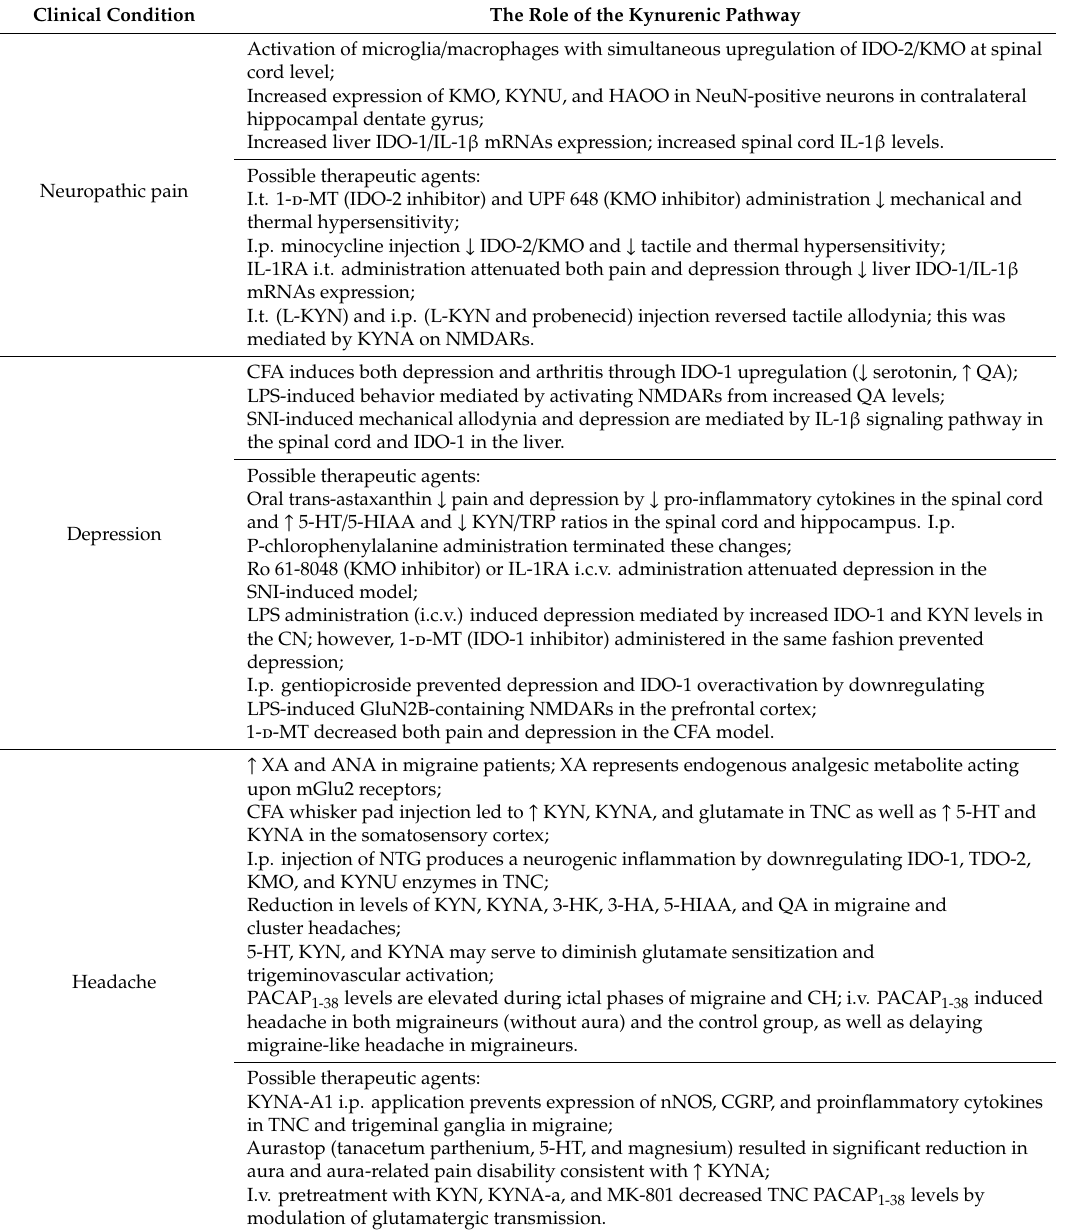
Table 1. Summary of changes in the kynurenine metabolic pathway in di ff erent clinical conditions with possible therapeutic